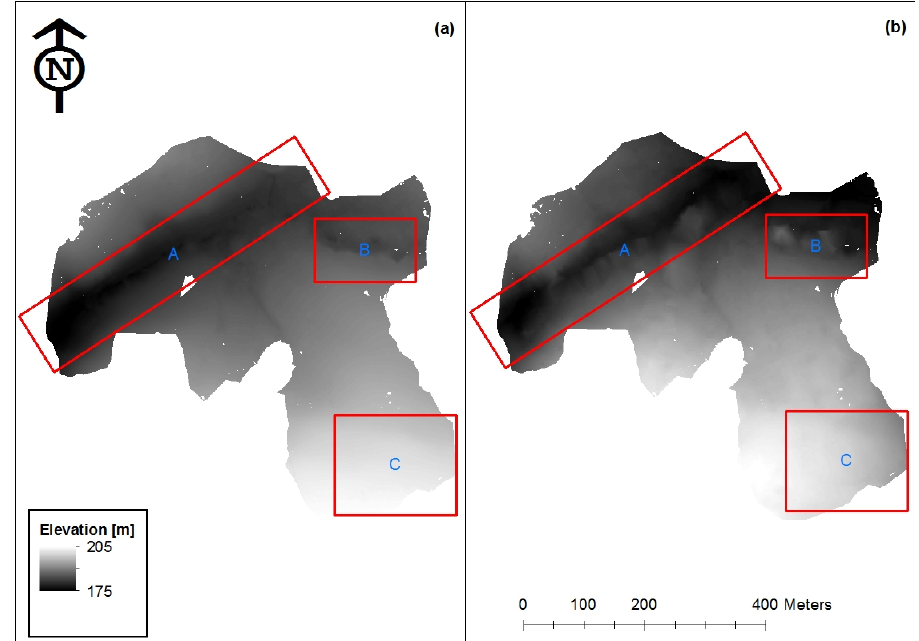
Figure 7. Showing ( a ) LiDAR DEM and ( b ) SfM DEM generated from the respective ground classified points at the Meshaw site. Boxes A and B show areas where the LiDAR had lower elevation than SfM, while in box C, LiDAR had higher elevation than SfM.